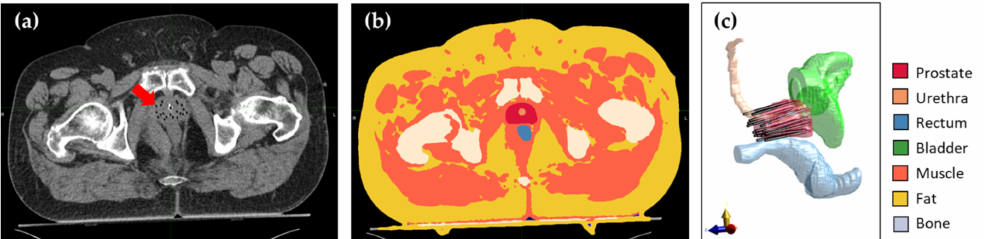
Figure 2. ( a ) Axial CT slice showing the anatomy of a patient with afterloading catheters (visible as black dots indicated by the arrow) inserted in the prostate. ( b ) Same axial slice of the resulting patient model after segmentation of all tissues. ( c ) Lateral 3D view of the prostate, OAR, and simulated TBT applicators in the same